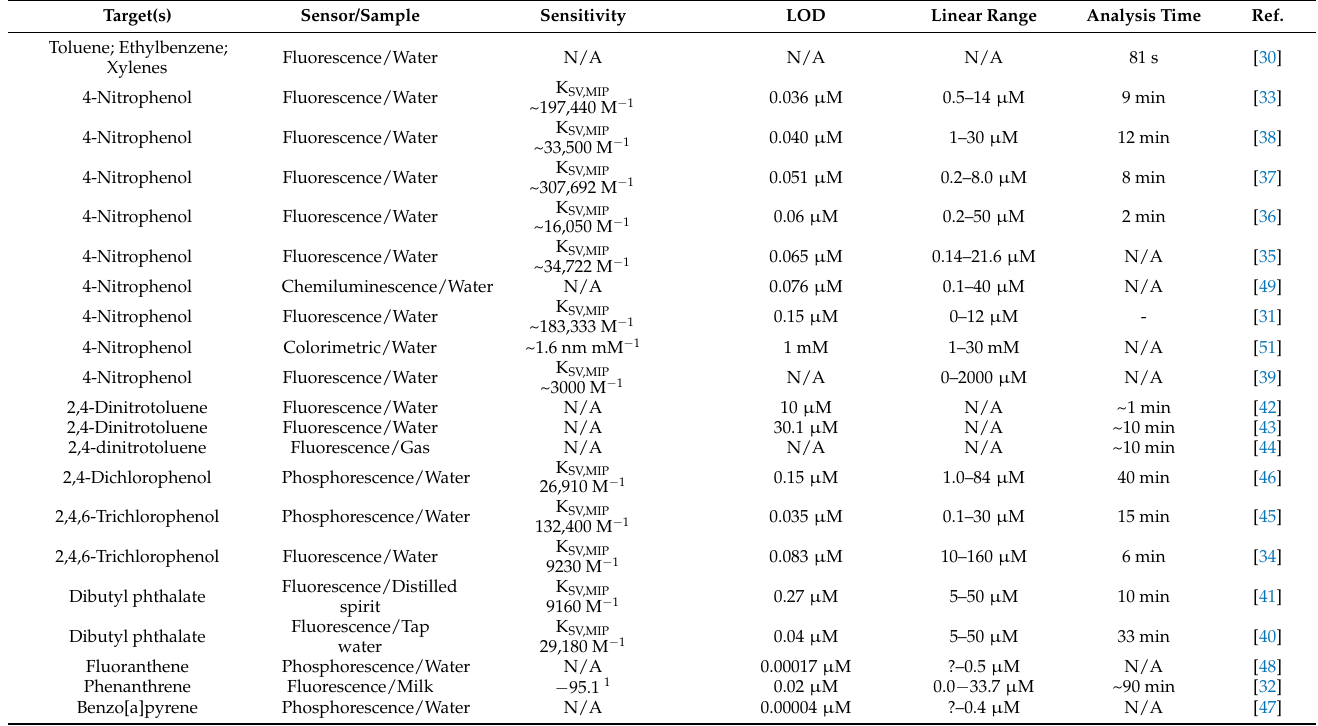
Table 1. Analytical characteristics of developed MIP-based optical sensors for EPA Priority Pollutants. The rows of the table are arranged based on the analytes and